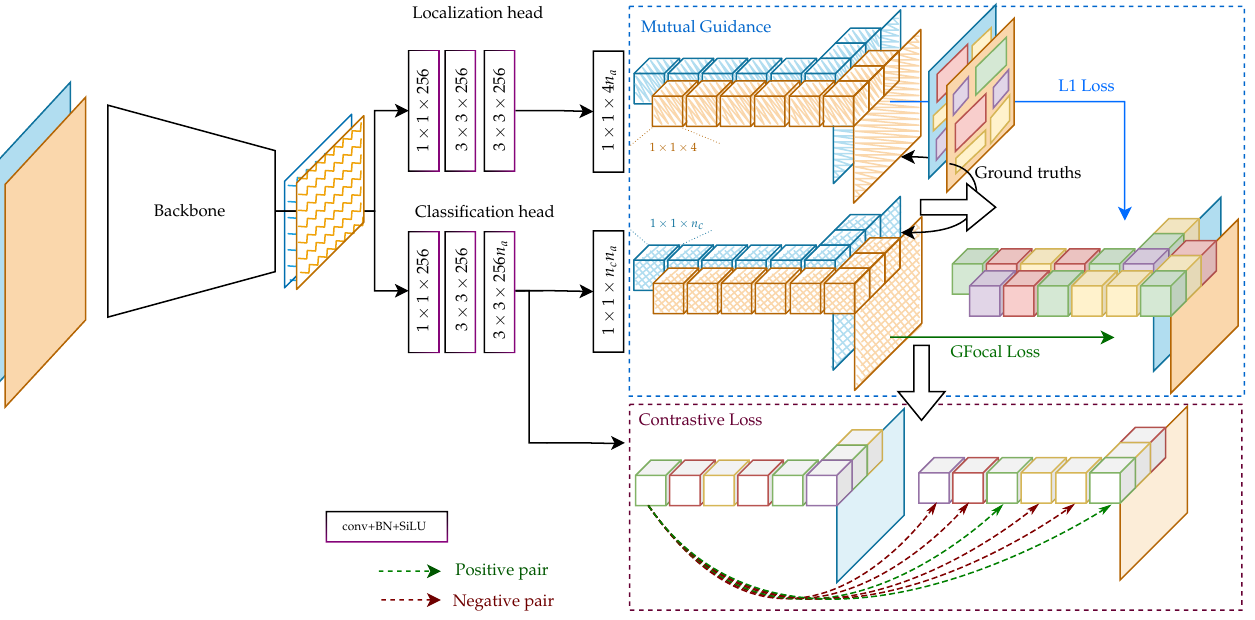
Figure 3. An overview of our framework: the backbone network encodes a batching input before passing the extracted features to the localization and classification heads, which predict 4-tuple bounding box values and n c -class confidence scores for each anchor box. The mutual guidance module re-ranks the anchor boxes based on semantic information from the classification branch and improves confidence score with localization information. The ground truth categories of the anchor boxes are used to supervise the contrastive loss. The pipeline is illustrated with batch size of 2 and the number of anchor boxes n a = 6.